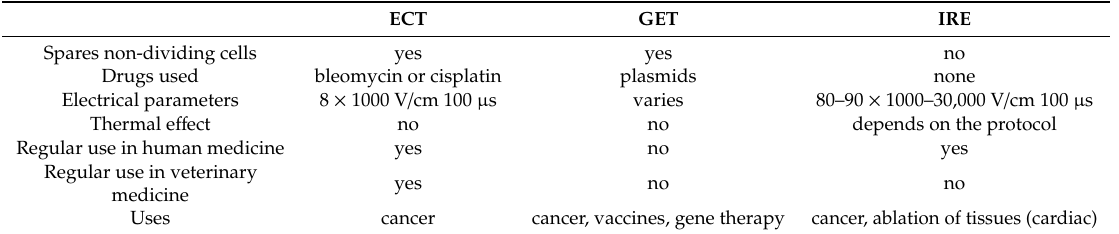
Table 1. Main characteristics of Electrochemotherapy (ECT), Gene Electrotransfer (GET) and Irreversible Electroporation (IRE).